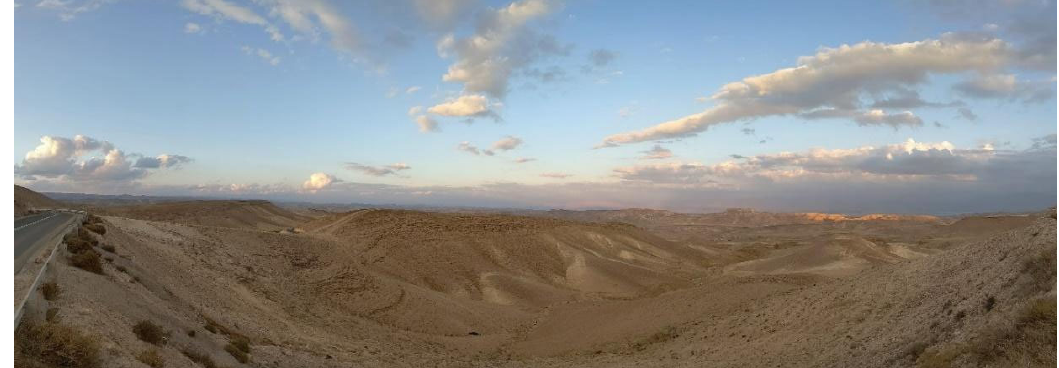
Figure 1. The “Negev” Desert Vista, Israel, 2019. On the left, the road between the cities of Arad and Massadah which runs through the Bedouin settlements of Al Baqi’a valley. Photographed by Dan Farberoff. Image courtesy of the artist.